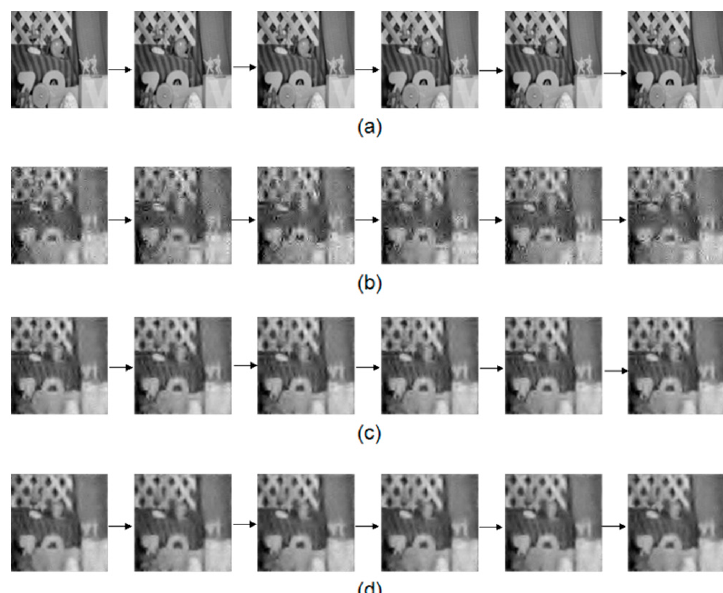
Figure 10. ( a ) The images from the original sample video; ( b ) The video recovered by the traditional